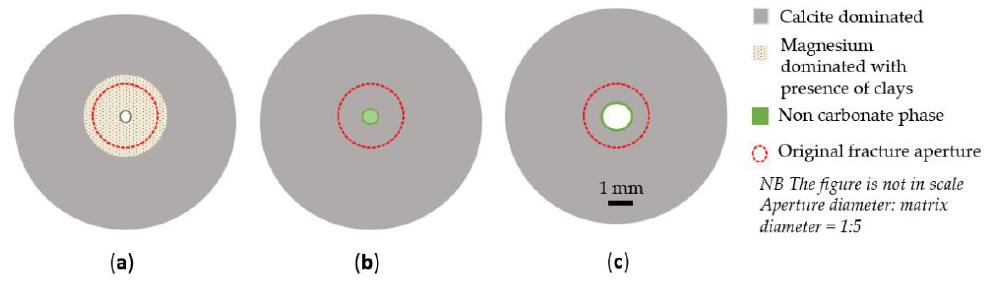
Figure 11. The sketch simplifies aperture modification and mineralogy in a cross-section for the three artificially fractured cores. All samples represent the third slice, where the apertures are most significantly reduced. The red circle symbolizes the original aperture size. ( a ) OBSV 4 AF-MgCl 2 ; ( b ) OBSV 12 AF-SSW; ( c ) OBSV 18 AF-NaCl.